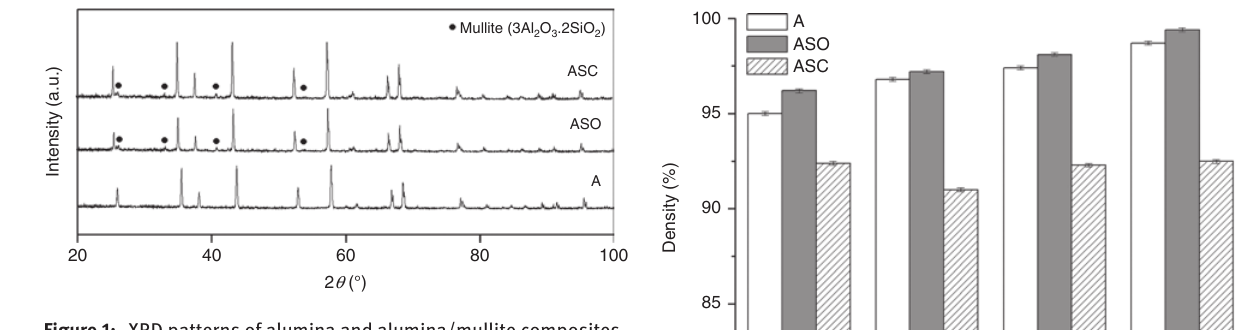
Figure 1: XRD patterns of alumina and alumina/mullite composites at 1400 ° C (dots show the presence of mullite).